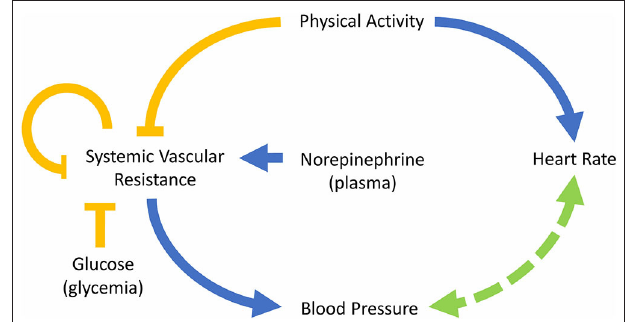
FIGURE 1 | Diagram of the model describing the interactions between the main variables involved in the control of blood pressure. The blue arrows indicate “activation,” the yellow arrows “inhibition” and the arrow with segmented line refers to a mutual regulation.